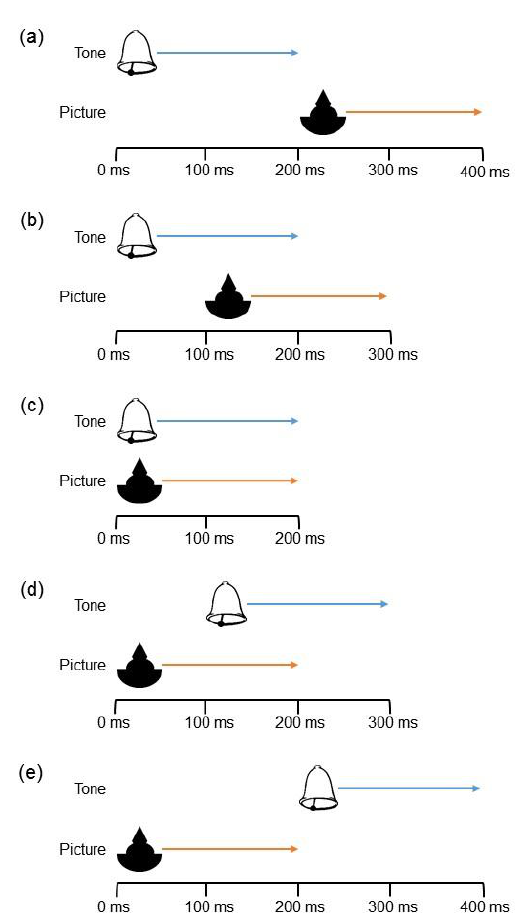
Figure 2. Stimulus timing. The duration of each stimulus was 200 ms. In the ( a ) + 200 Auditory condition and ( b ) + 100 Auditory condition, the auditory stimulus preceded the visual stimulus. In the ( c ) Simultaneous condition, the stimuli were presented at the same time. In the ( d ) + 100 Visual condition and ( e ) + 200 Visual condition, the visual stimulus preceded the auditory stimulus.